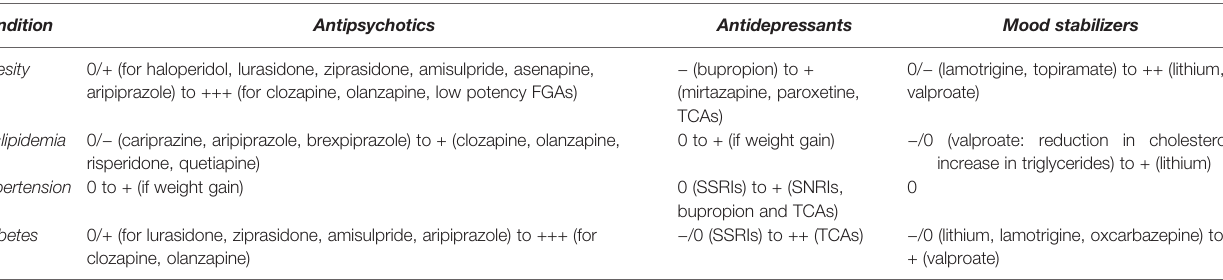
TABLE 1 | Impact of psychotropic medication on obesity and other metabolic abnormalities in people with SMI.